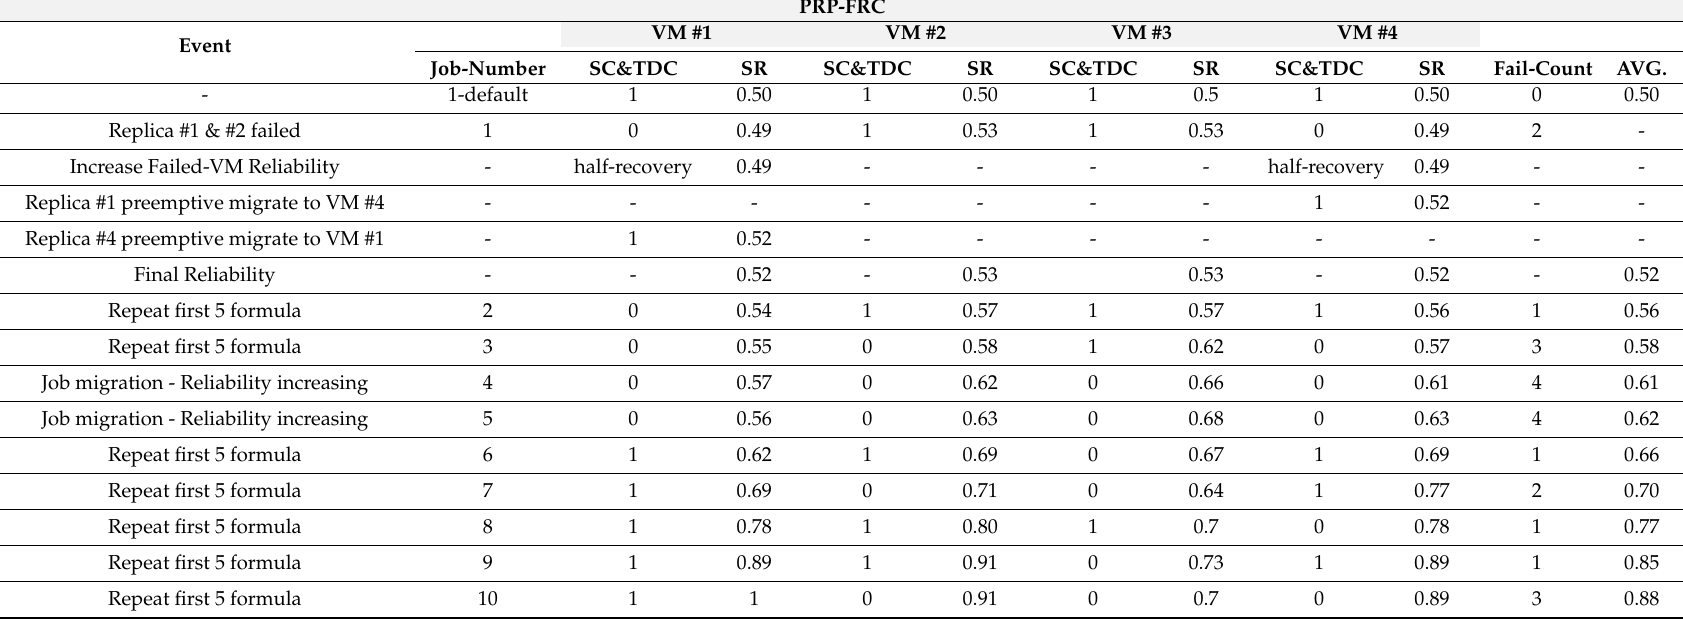
Table 8. Results of simulating PrP-FRC in